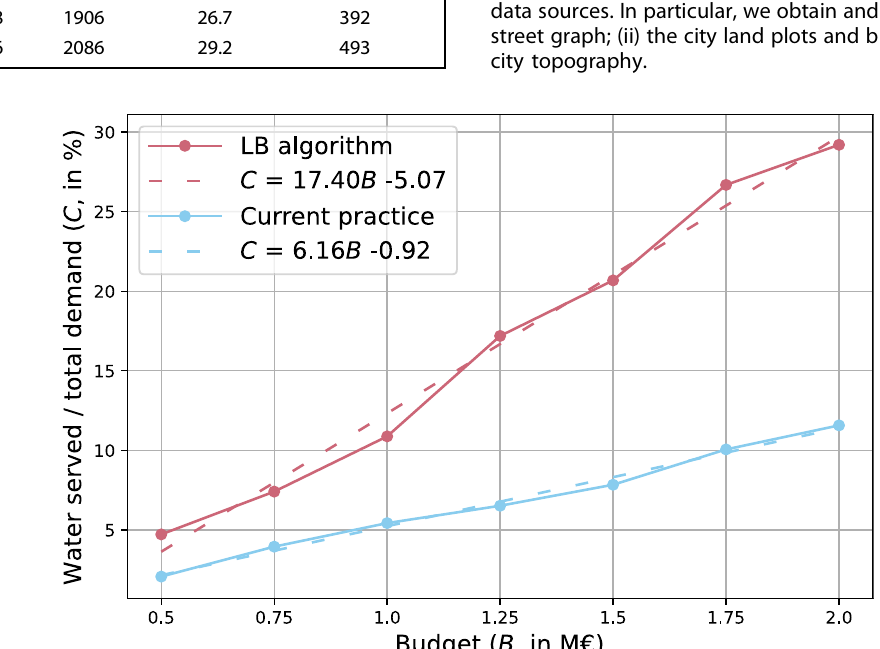
Fig. 4 LB algorithm water served per budget results, compared with current practice. Percentage of water served over total demand comparison between the LB algorithm and current practice (manual approach). The linear regression functions for both the LB algorithm and current practice are de fi ned in the fi gure legend and represented as dotted